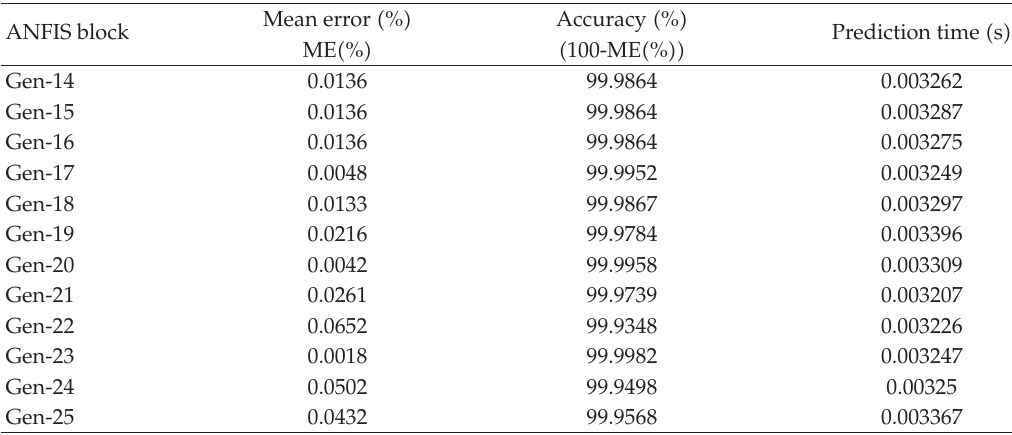
Table 1: Performance of individual ANFIS